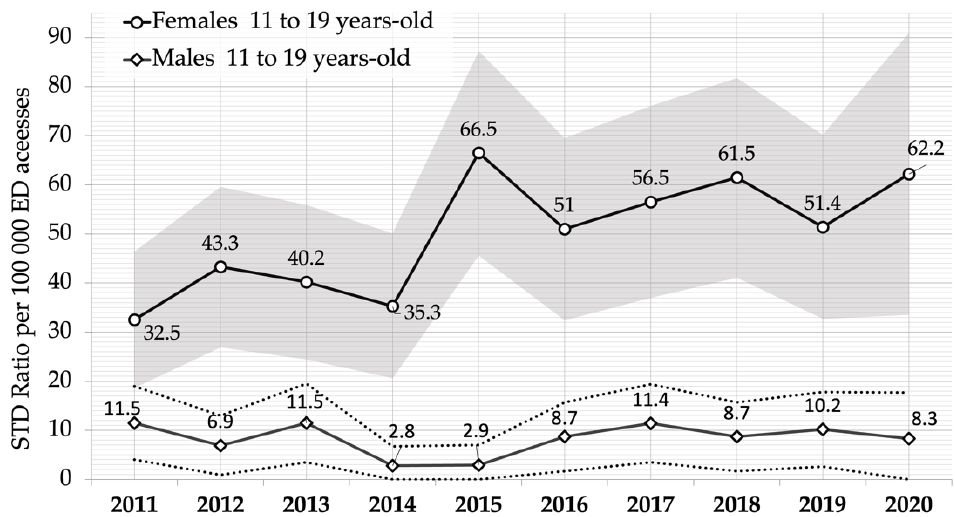
Figure 2. Ratio of sexually transmitted infections (STIs) admissions to the ED per 100,000 visits and 95% confidence intervals (grey and dotted areas), in adolescents aged 11–19 years, by sex. Year 2011–2020, Piedmont region,